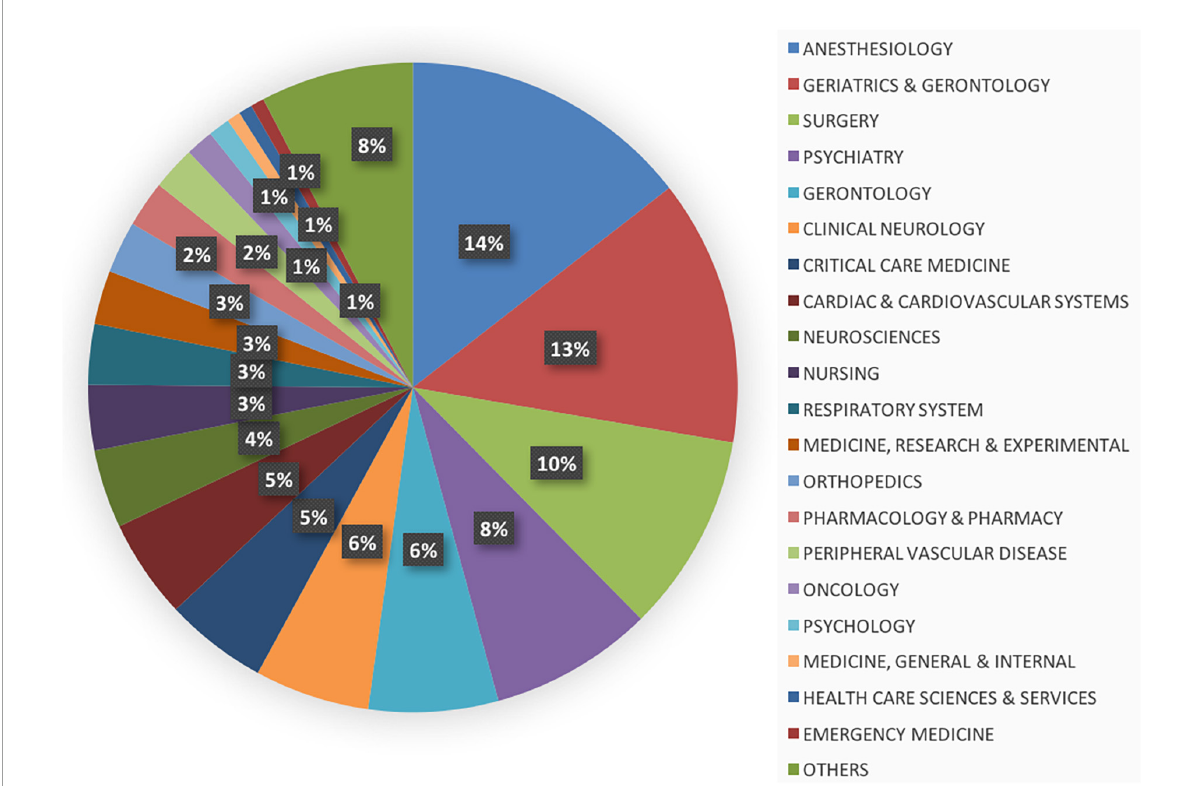
FIGURE5 The distribution of top 20 subjects associated with the field of postoperative delirium